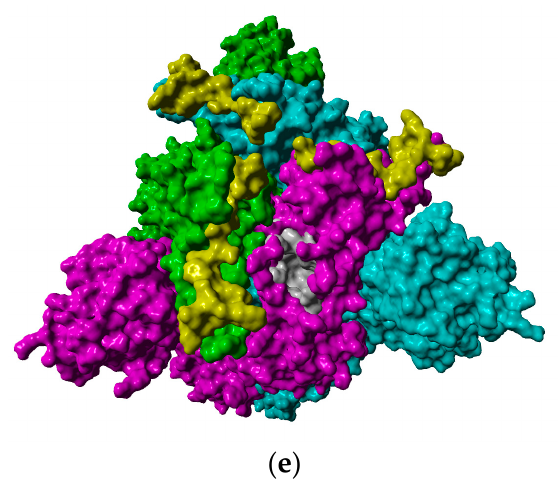
Figure 1. Lateral view of spike protein in its ( a ) open and ( b ) closed conformations. Subunits A, B and C are colored in cyan, green, and magenta, respectively. The fatty acid-binding pocket is colored in white, and the site for angiotensin-converting enzyme (ACE) binding is colored in yellow. A closer view of the fatty acid binding pocket, with most relevant residues labeled, is shown in ( c ). Upper views of both open ( d ) and closed ( e ) conformations are also shown.